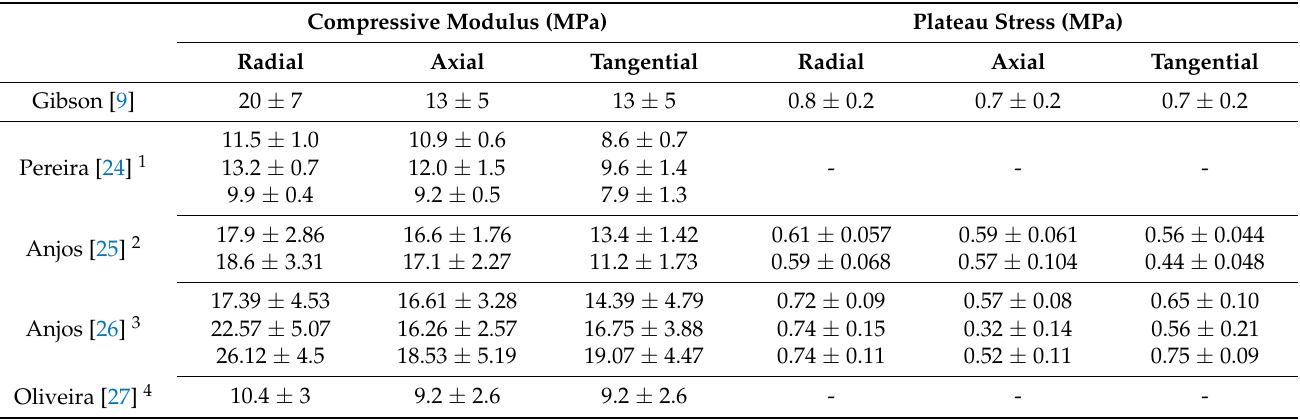
Table 3. Compressive modulus and plateau stress at 5% of strain values provided by different authors for the three main directions of natural